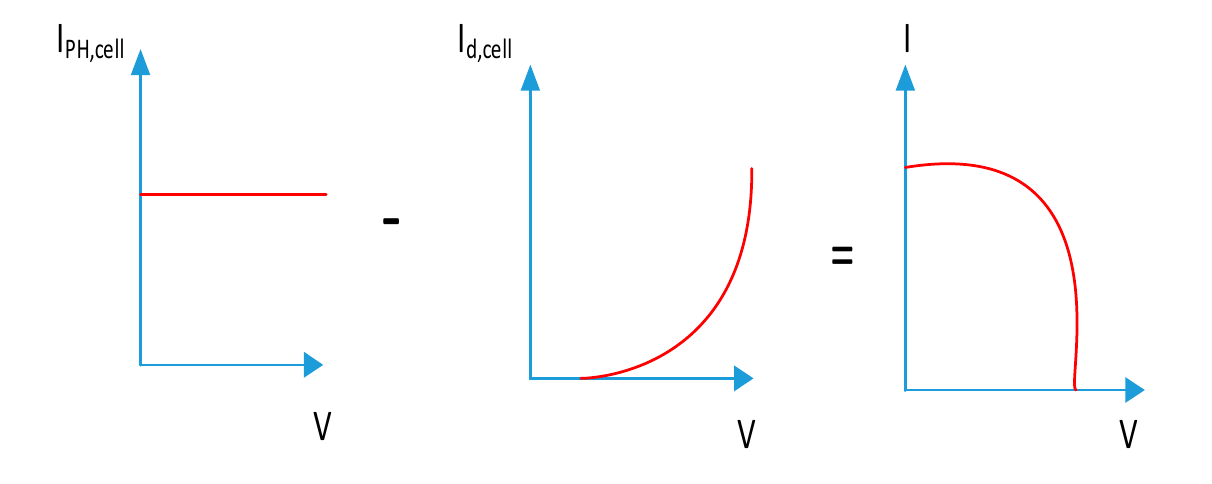
Figure 5. A typical current and voltage curve of photovoltaic. Photovoltaic Modeling